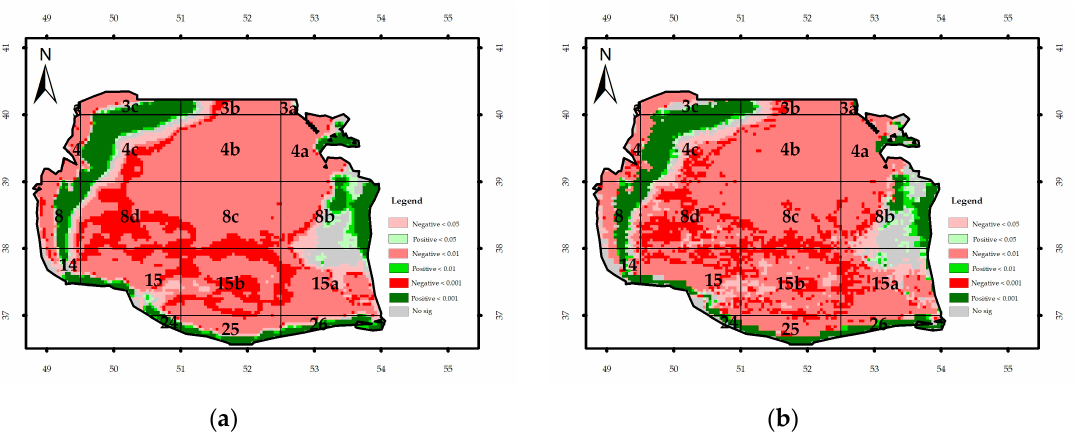
Figure A5. Significance of monthly trend of Rrs_555nm: ( a ) Regional Mann–Kendal and ( b ) Mann– Kendal.